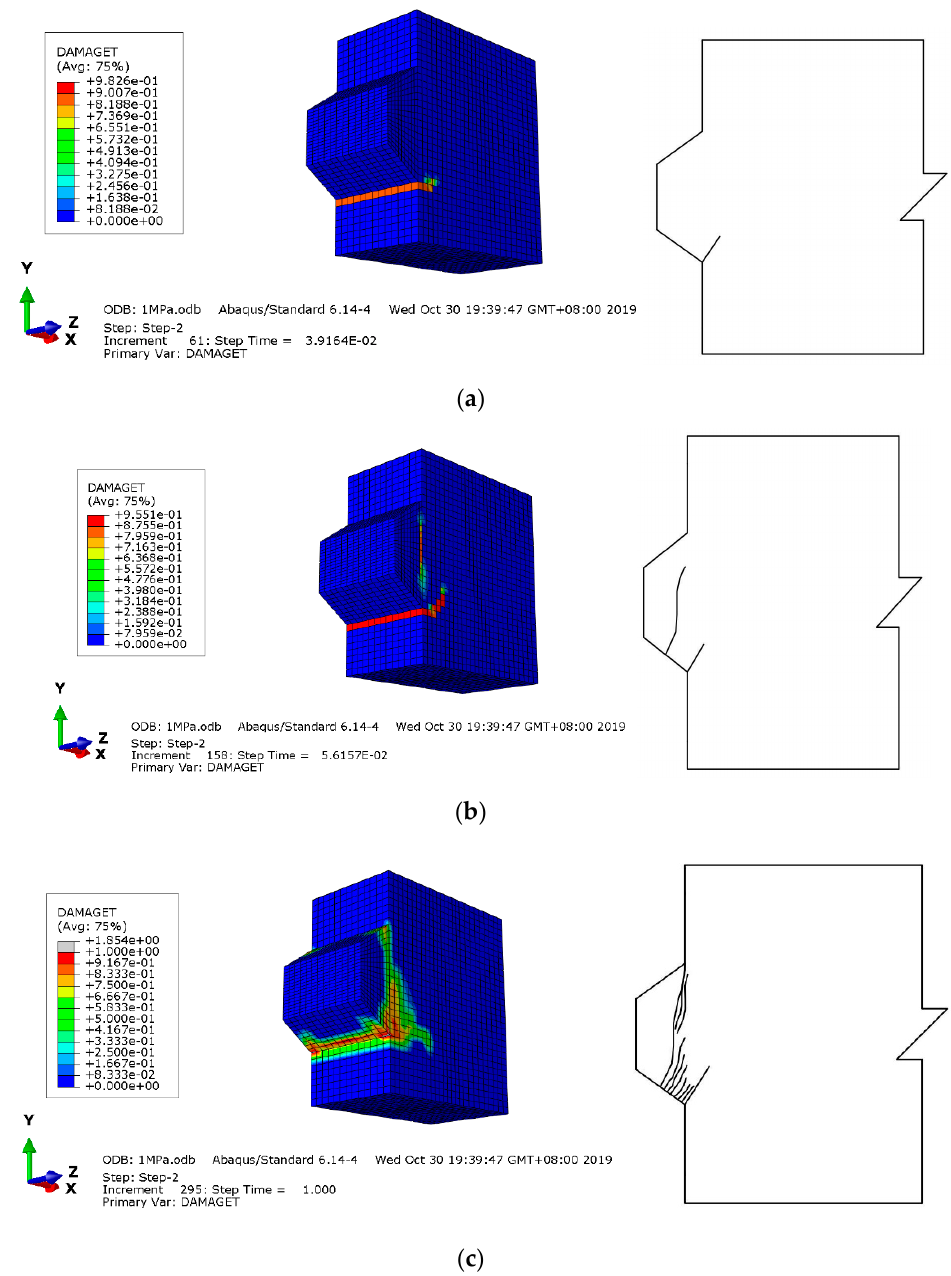
Figure 7. Tension damage distribution diagram and crack development process; ( a ) load to point A; ( b ) load to point B; ( c ) load to point C.